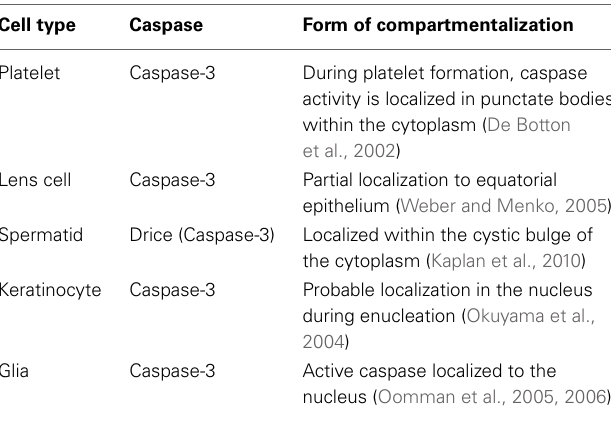
Table 3 | Compartmentalization of caspases has been found to be used in the differentiation programs of several cell